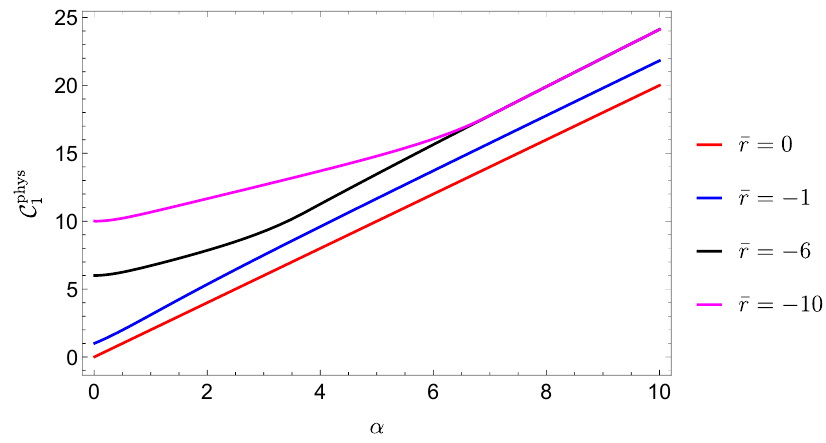
(^ (cid:26) 1 ) as a 1